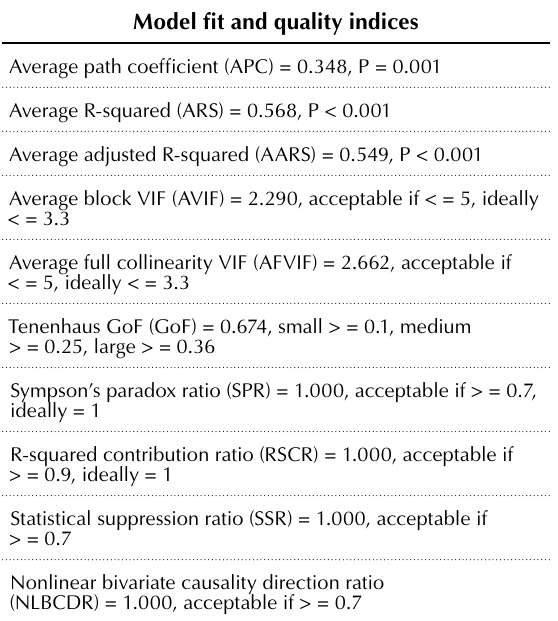
Table 8. Model fit and quality indices Model fit and quality indices